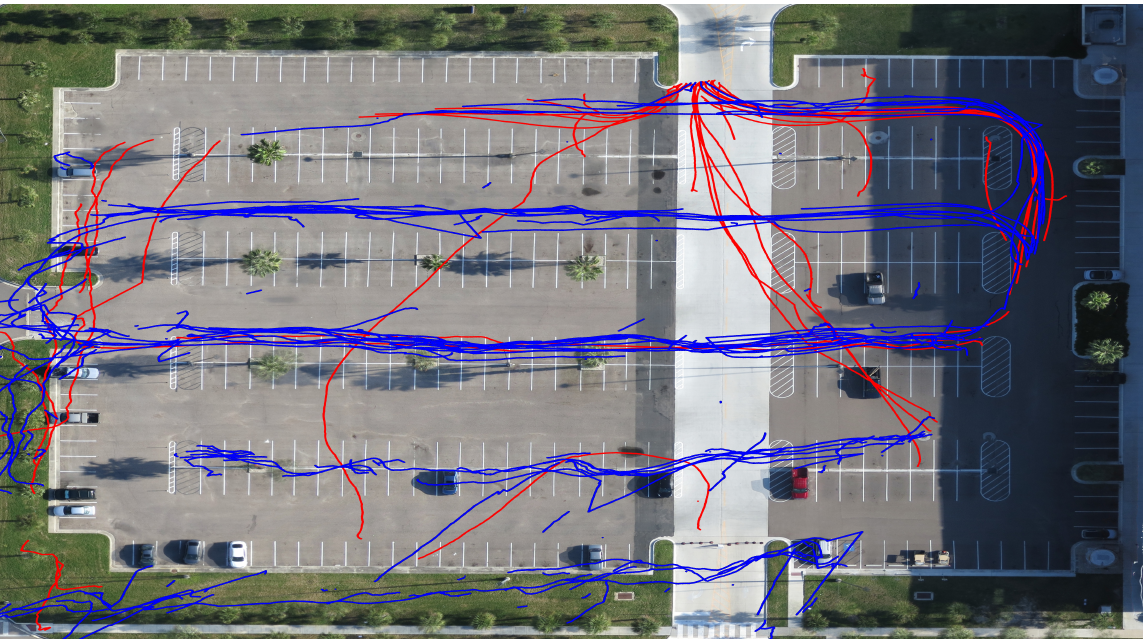
Figure 11. A visualization of the transformed coordinate accuracy output from the computer vision pipeline combined with the results of the monoplotting registration. The low traffic patterns are shown in red, and the high traffic patterns in blue. Note that as distance from the camera origin in the top right increases, coordinate transformations become less stable. There are also some triangular shapes present in the blue tracking lines which can be cross-referenced with Figures 8 and 9 to identify the effects of lens